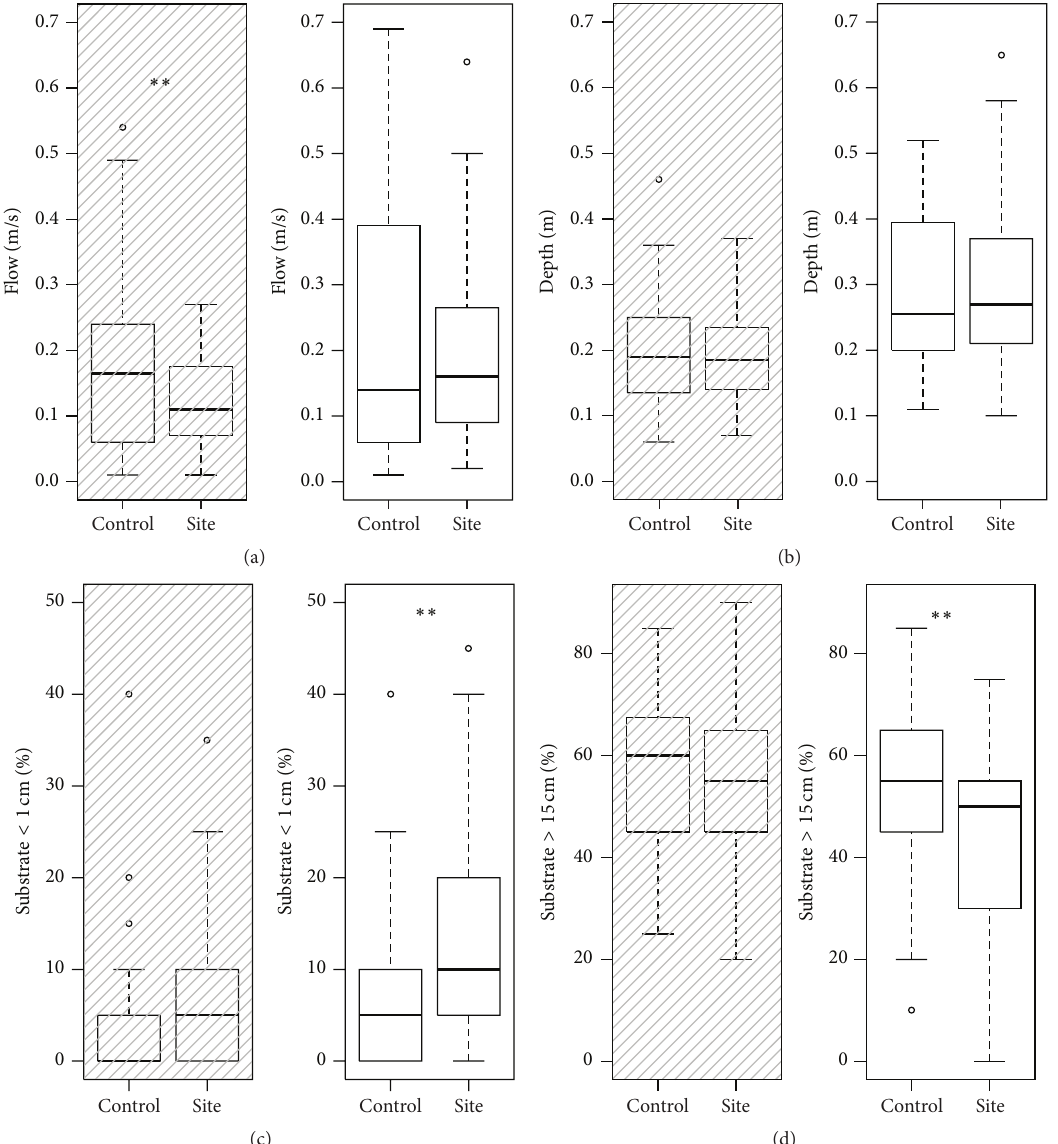
Figure 1: Boxplots showing the median, first and third quartiles, and 95% CI of different physical habitat measurements within a 1m radius of occupied central place foraging sites (Site) of Atlantic salmon ( Salmo salar ) fry compared to unoccupied control sites (Control) 2 m directly upstream in two neutral (open plots) and two acidic (shaded plots) streams. (a) Depth (m); (b) flow rate (m s −1 ); (c) percent substrate particles < 1cm diameter; (d) percent substrate particles > 15 cm diameter ( 𝑛 = 40 per box). Asterisks denote significant differences from zero in one- sample 𝑡 -tests ( ∗∗ 𝑃 < 0.01 ).